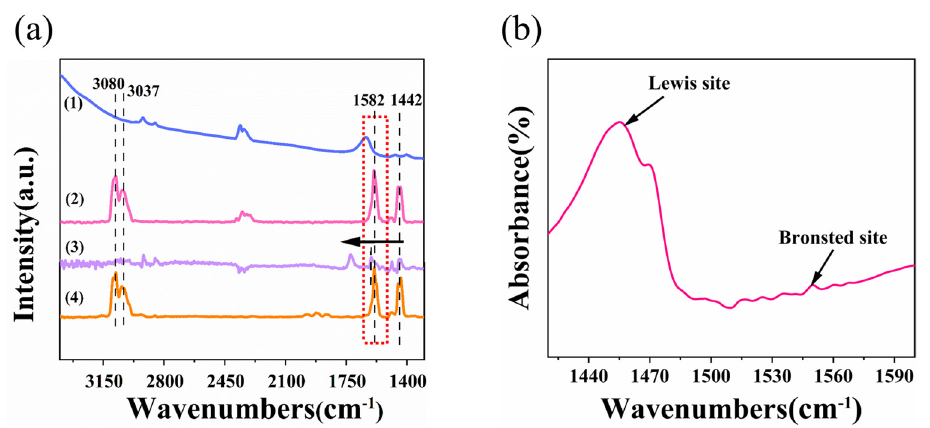
Figure 7. ( a ) In situ FTIR spectra of Pd/ZIS: (1) after degassing in vacuum at 180 °C for 2h, (2) adsorbing pyridine for 1 h at room temperature (physisorption and chemisorption), (3) further degassing in vacuum at 150 °C for 30 min (chemisorption), and (4) FTIR spectra of pyridine; ( b ) Fourier transform infrared spectrum of 1% Pd/ZIS during pyridine adsorption.